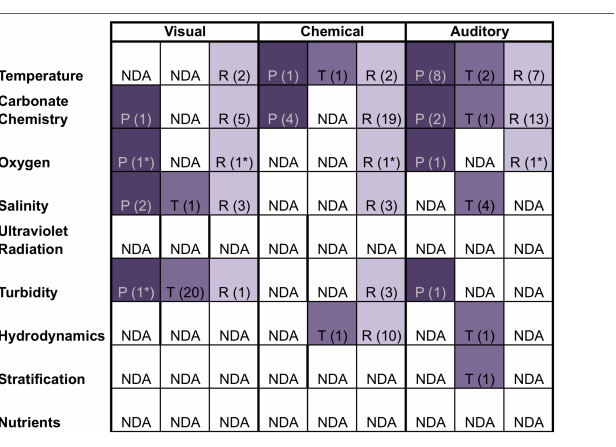
TABLE 1 | Steps of sensory pathways and associated sensory modalities that are affected by aspects of human-caused ocean changes to specific physical attributes of the marine